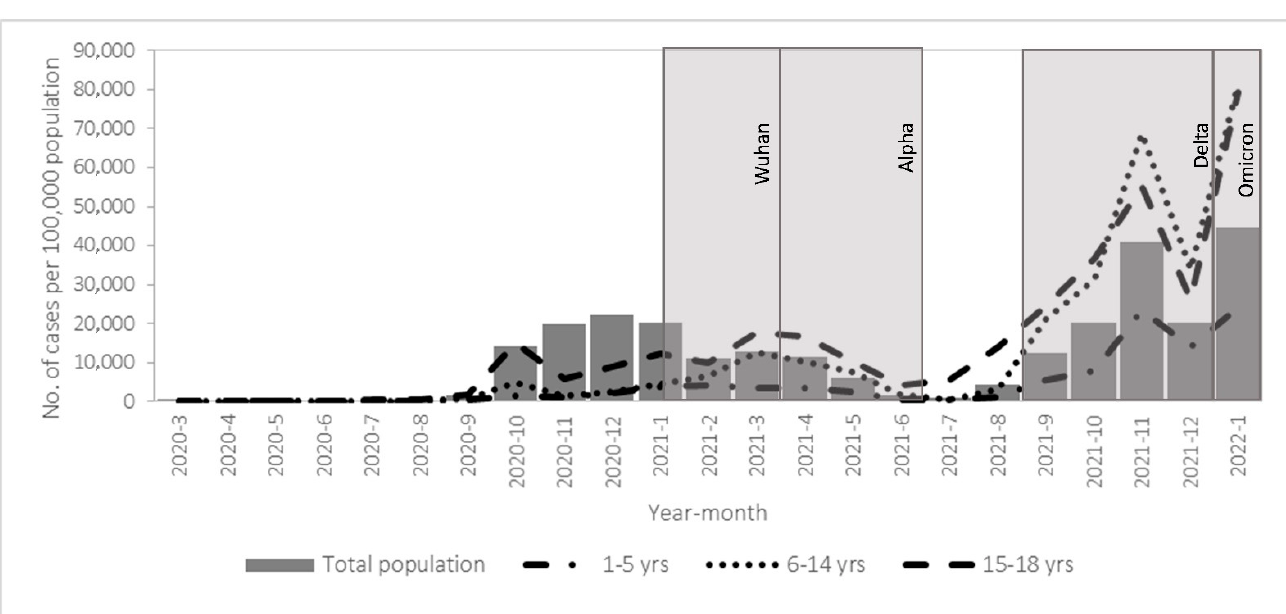
Figure 1. Monthly incidence rate of SARS-CoV-2 cases per 100,000 population by age group and total population in Slovenia, period 4 March 2020–18 January 2022. The periods of the predominant variant of the SARS-CoV-2 virus during the period of open ES are marked in the shaded fields.